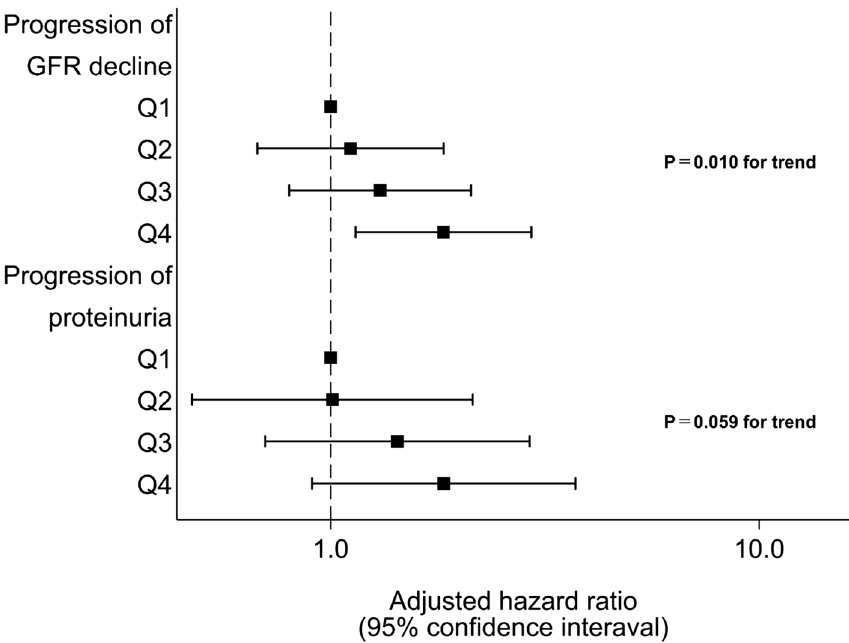
Figure 3. Effects of pulse pressure quartile on eGFR decline or progression of proteinuria. Adjusted hazard ratios and 95% confidence intervals associated with pulse pressure quartile for progression of eGFR decline or proteinuria were obtained, controlling for sex, age, diabetes mellitus, dyslipidemia, hyperuricemia, obesity, current smoking and drinking alcohol, and baseline eGFR and proteinuria. Boxes and vertical lines represent hazard ratios and 95% confident intervals,